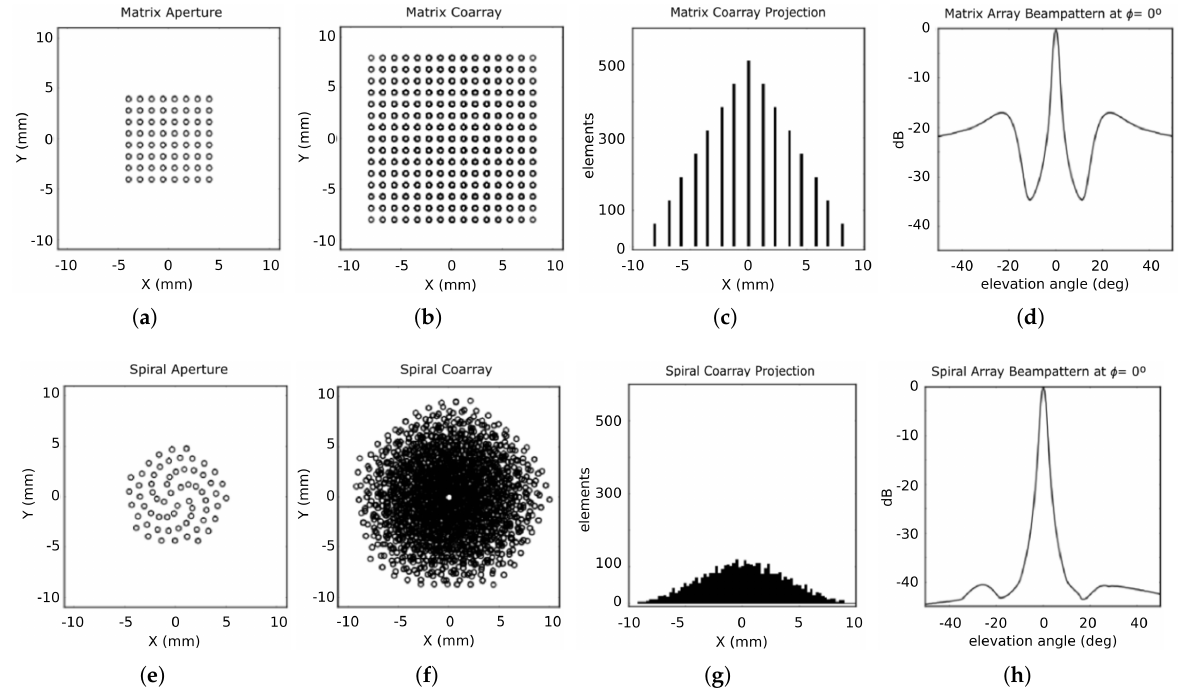
Figure 1. For Matrix arrays: ( a ) array footprint or aperture; ( b ) coarray footprint; ( c ) equivalent linear array projection at φ = 0 ◦ , and ( d ) beampattern at φ = 0 ◦ (wideband response, BW = 60%). For spiral array aperture: ( e ) array footprint; ( f ) coarray footprint; ( g ) equivalent linear array projection at φ = 0 ◦ , and ( h ) beampattern at φ = 0 ◦ (wideband response, BW =